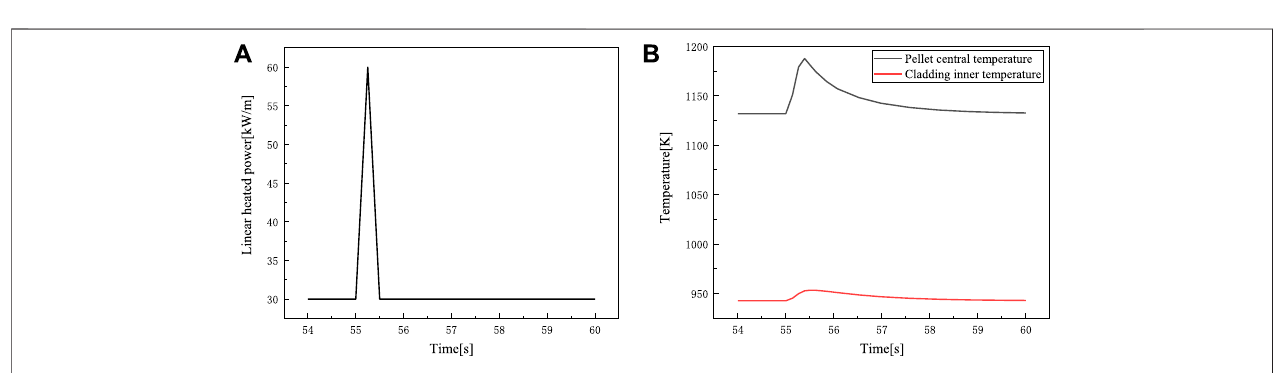
FIGURE 4 | Reactivity Initiated Accidents events. (A) the change of linear heated power. (B) the change of the maximum temperature of pellet and cladding.